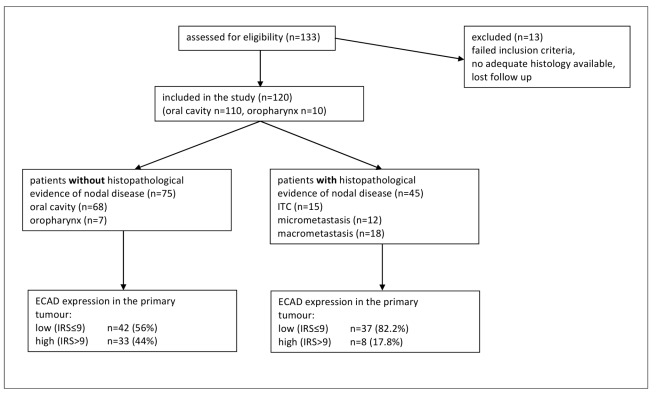
Example of a participant flow diagram [177].